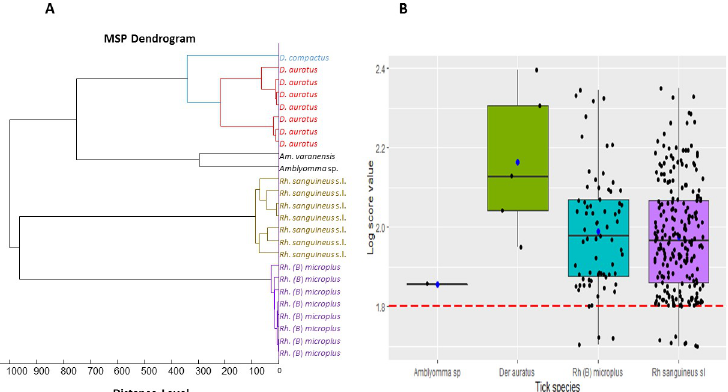
Fig 3. Comparison of MALDI-TOF MS spectra from the legs of six alcohol-preserved tick species collected in Vietnam and stored for different periods of time. The dendrogram was built using between one and eight representative MS spectra from six distinct tick species (A). The MS spectra of different specimens showed intra- species reproducibility and inter-species specificity as confirmed by PCA